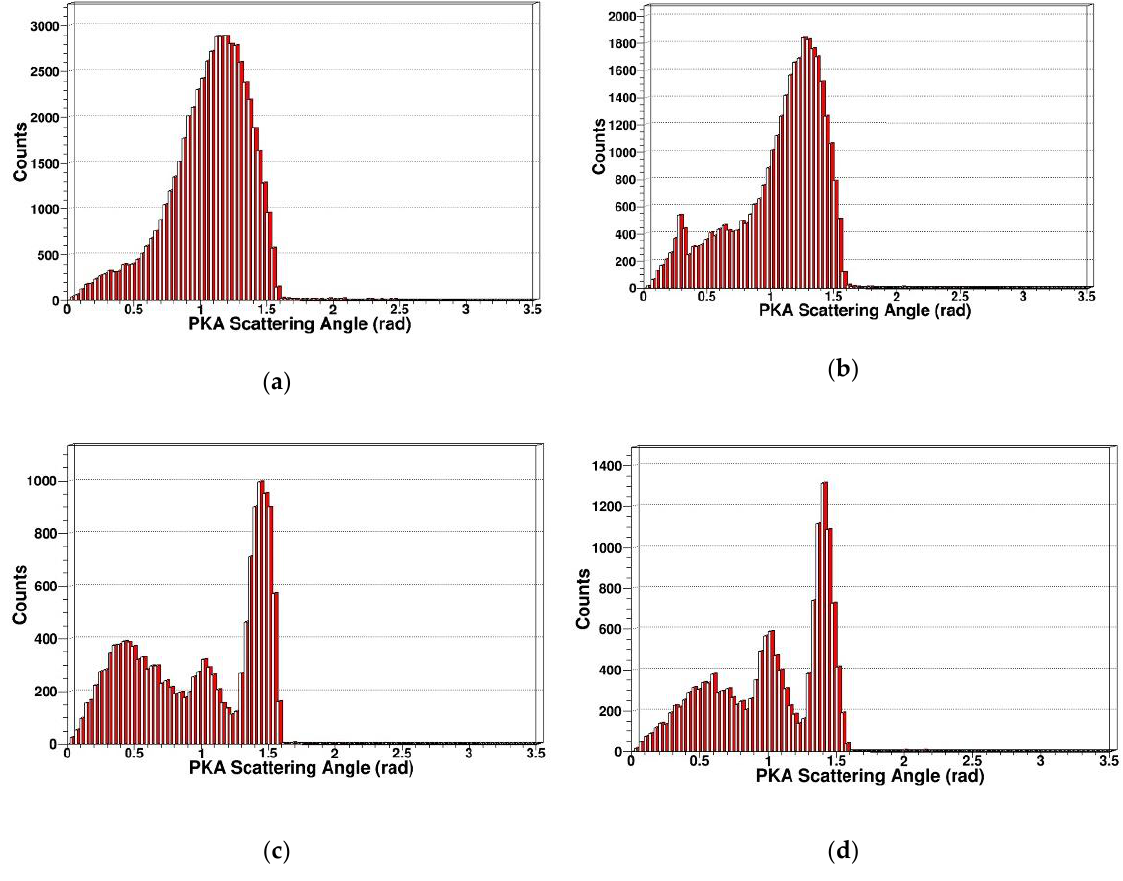
Figure 6. PKA scatting angle in SDD generated by neutrons: ( a ) PKA scatting angle for 1 MeV neutrons; ( b ) PKA scatting angle for 2 MeV neutrons; ( c ) PKA scatting angle for 14 MeV neutrons; ( d ) PKA scatting angle for 20 MeV neutrons.